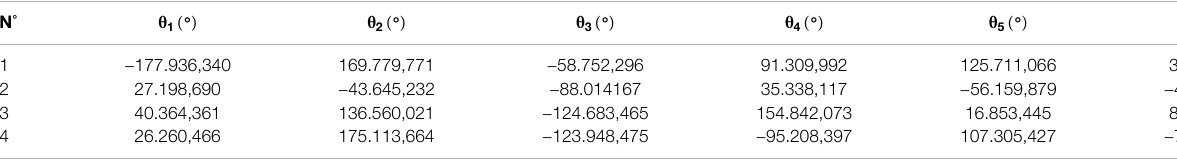
TABLE 4 | Joint angles according to the algorithm.